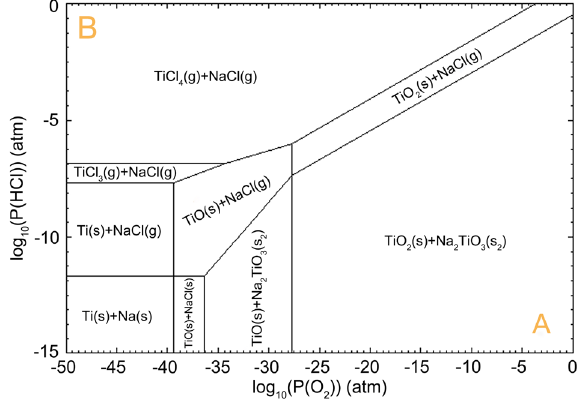
Fig. 8 The phase-stability diagram for Ti-Na-Cl-O-H at 600 °C calculated using FACTSAGE have been consumed. In this work, as shown in Fig. 3a, b, corrosion reactions occurred around solid NaCl on the surface of the sample at the initial time. With the deposition and consumption of NaCl, as shown in Fig. 3c – g, the morphology of NaCl does not present sharp edges but present rounded edges, which may attest to their progressive gas releasing. NaCl reacts with TiO 2 in presence of O 2 and H 2 O, leading to the formation of